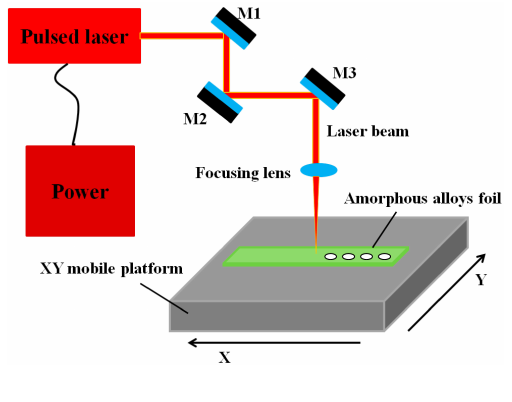
Figure 2. Experimental set up of laser drilling micro